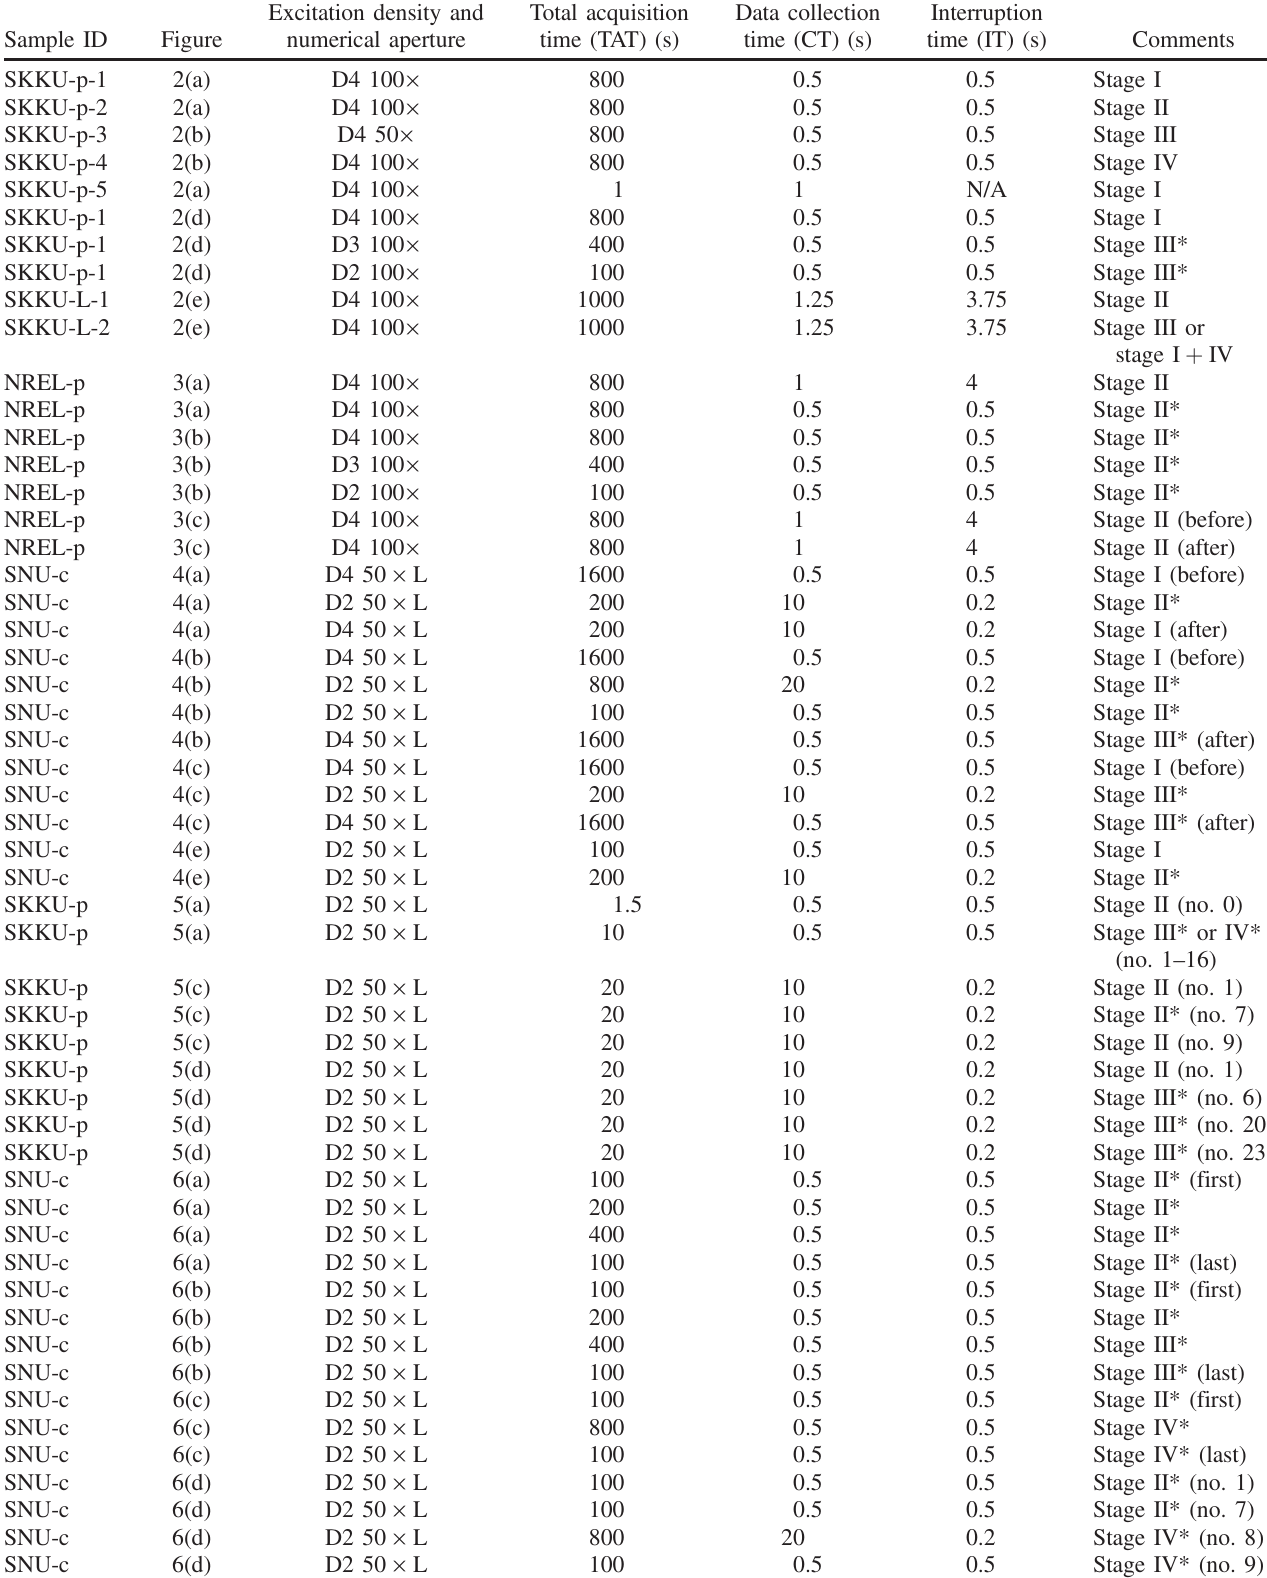
TABLE I. Summary of Raman data in Figs. 1 – 6. The asterisk indicates a light-induced degradation state. Sample